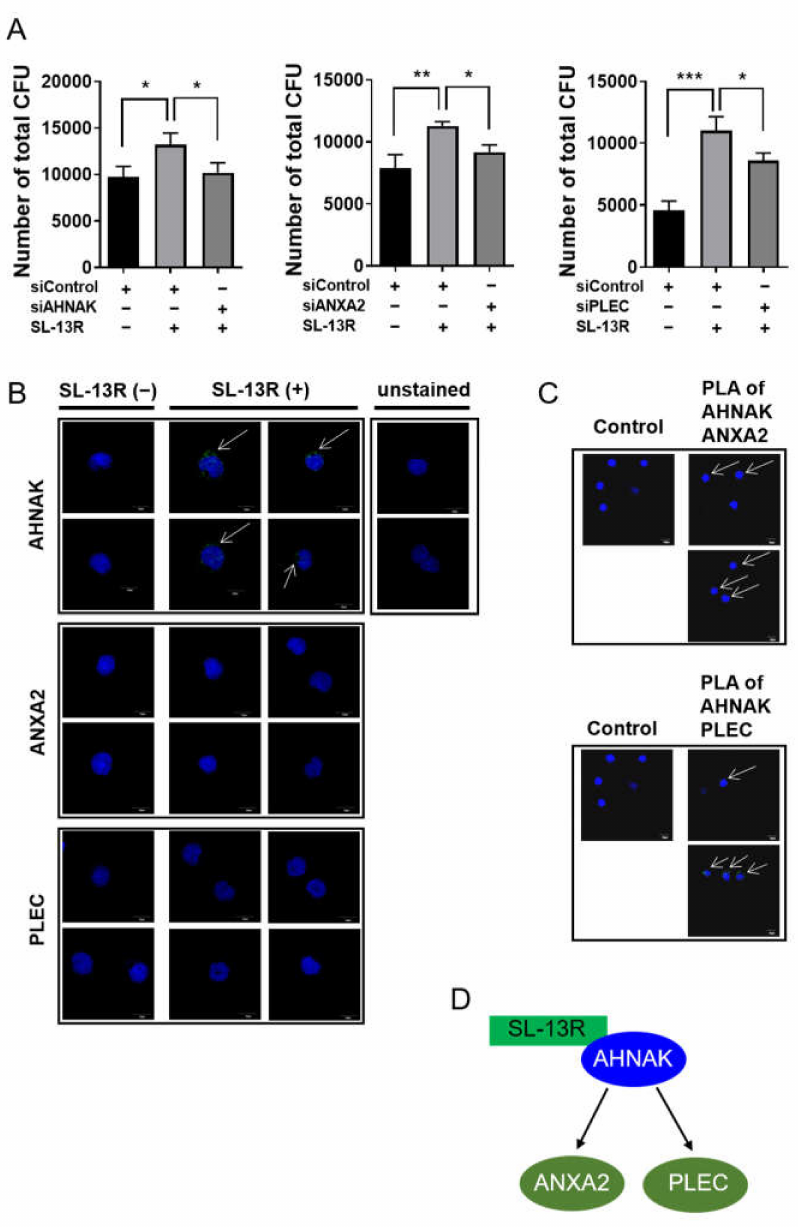
Figure 5. SL-13R directly binds with AHNAK. ( A ) Number of total CFU. After siRNA transfection, the cells were cultured with or without SL-13R for 3 days and performed CFU assay ( n = 3). One- way analysis of variance followed by Tukey’s post hoc test was used to test intergroup